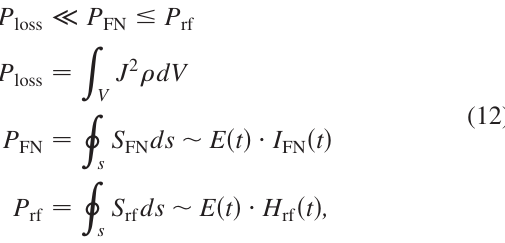
tip. Arrows show the direction and the color code is proportional to the logarithm of the absolute value of the associated Poynting